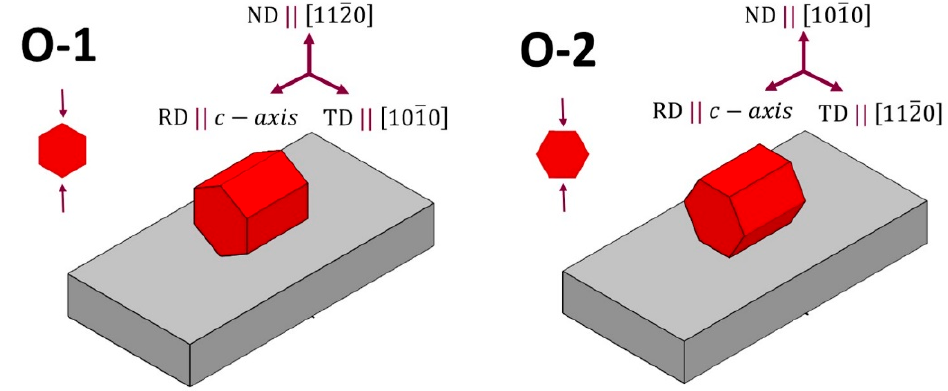
Figure 1. Single crystal orientations (O) for the rolling experiments.